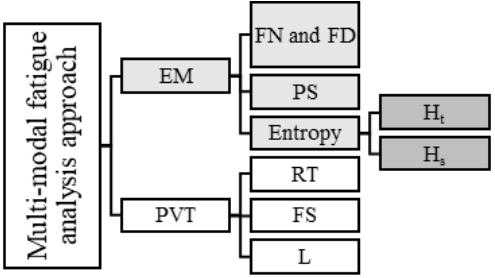
Figure 1. Measures used to investigate fatigue for a multiphase flight task: FN is eye fixation numbers, FD is eye fixation durations, PS is pupil size, Ht is transition visual entropy, Hs is stationary visual entropy, RT is reaction times, FS is number of false starts, and L is number of lapses.